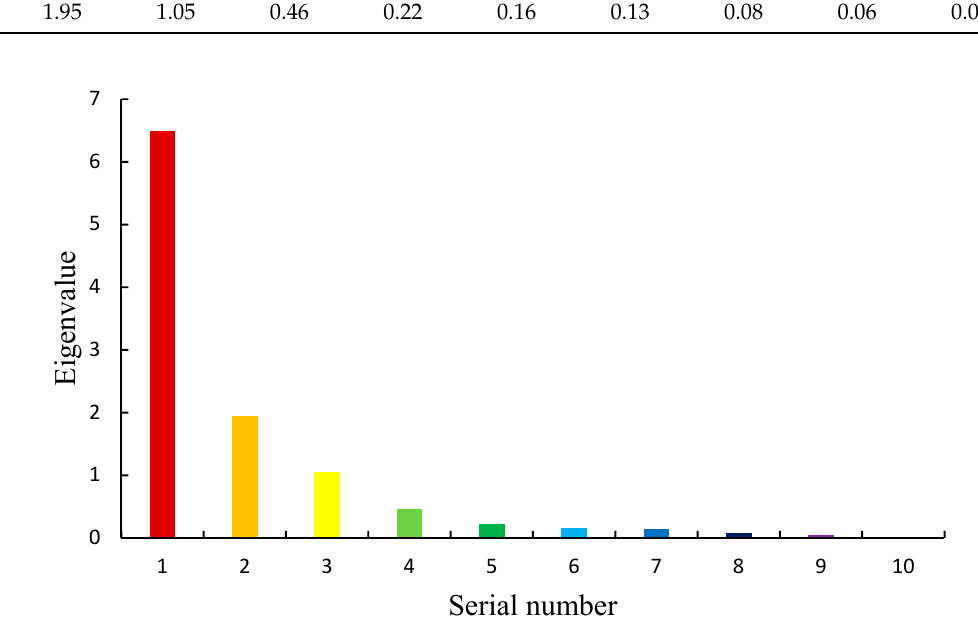
Figure 5. Distributions of the 10 largest eigenvalues.